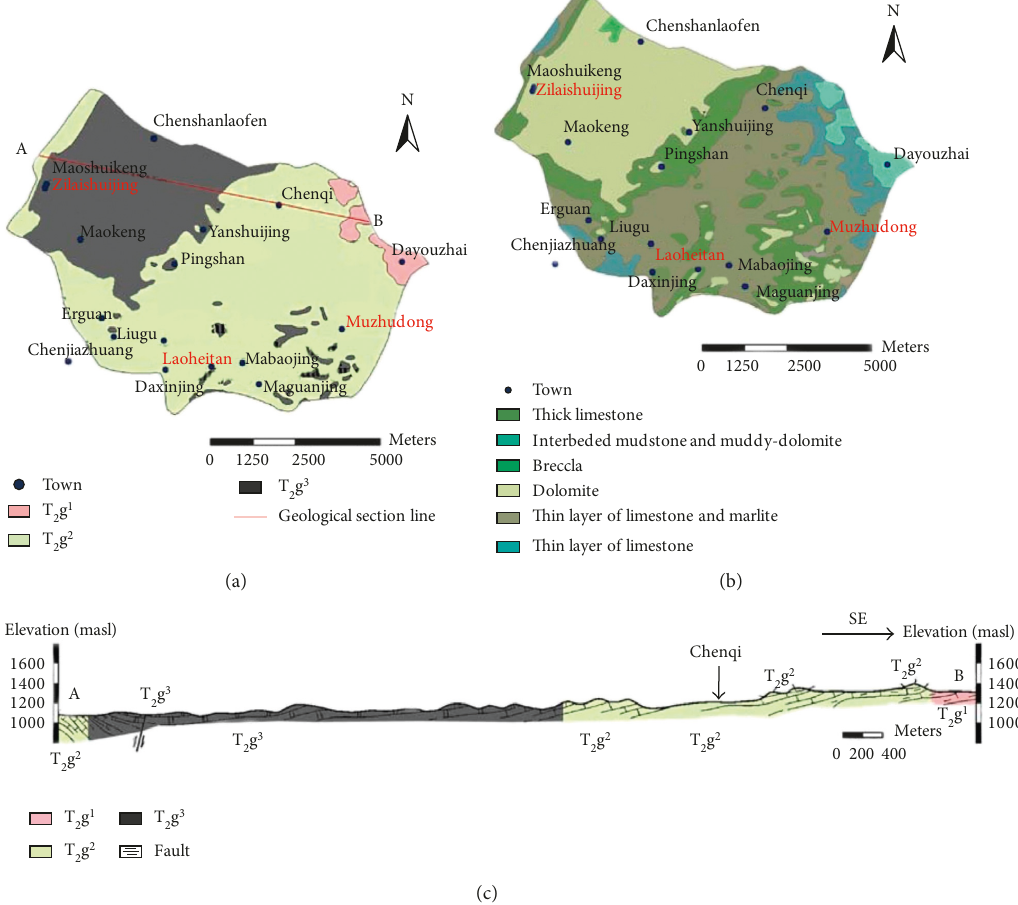
Figure 2: The formation and lithology of the Houzhai karst basin. (a) Members of the Guanling Formation. (b) Lithology. (c) Simplified geological cross-section AB